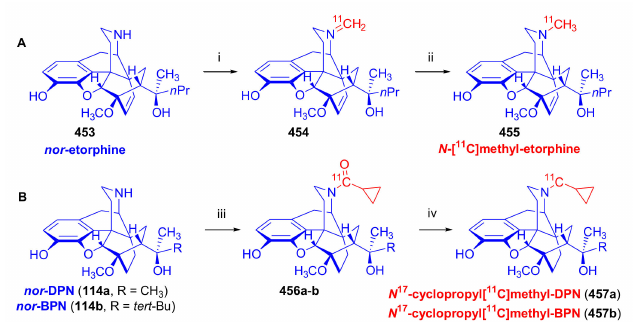
Figure 113. Synthesis of selected 11 C-labeled orvinol derivatives. A . Synthesis of N -[ 11 C]methyl- etorphine. B . Synthesis of N -cyclopropyl[ 11 C]methyl-BPN and N -cyclopropyl[ 11 C]methyl-BPN. Reagents and conditions : (i) H 11 CHO, AcOH, CH 3 CN, − 5 ◦ C; (ii): NaBH 3 CN, 70 ◦ C, 5 min.;